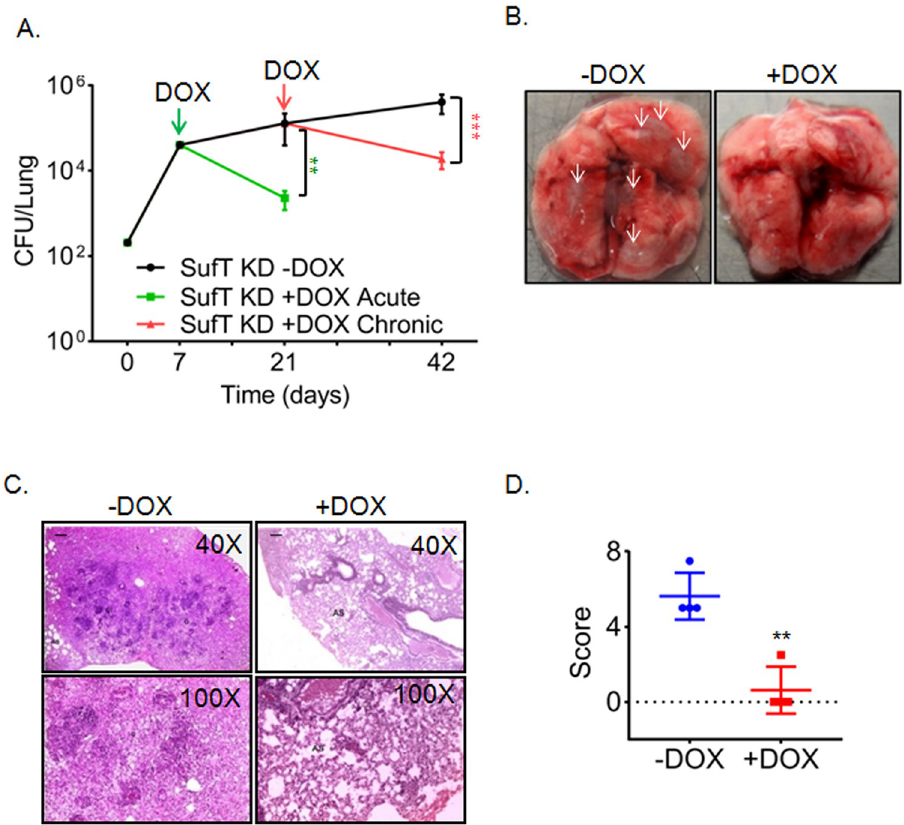
Fig 8. SufT is required in acute and chronic phase of infection in vivo . (A) BALB/c mice (n = 6) were aerosol infected with SufT-KD strain at 200 CFU per lung at 0 day and divided into three groups of i) SufT-KD -DOX (no doxycycline treatment), ii) SufT-KD +DOX Acute (DOX started at 7 days after infection) and iii) SufT-KD +DOX Chronic (DOX started at 21 days after infection). Post infection six animals were sacrificed from each group on day 7, 21 and 42 and CFU load per lung was measured. (B) Gross pathology of lungs (upper panel) from SufT-KD -DOX and +DOX infected BALB/c mice was shown after 42 days of infection. White arrows indicate distinct granulomas. (C) Hematoxyline and eosin- stained lung sections after 42 days of infection. (D) Histo-pathological granuloma scoring of lung sections from–DOX and + DOX infected BALB/c mice. Student’s t test (two tailed) was performed to determine statistical significance as �� p � 0.01 and ��� p �